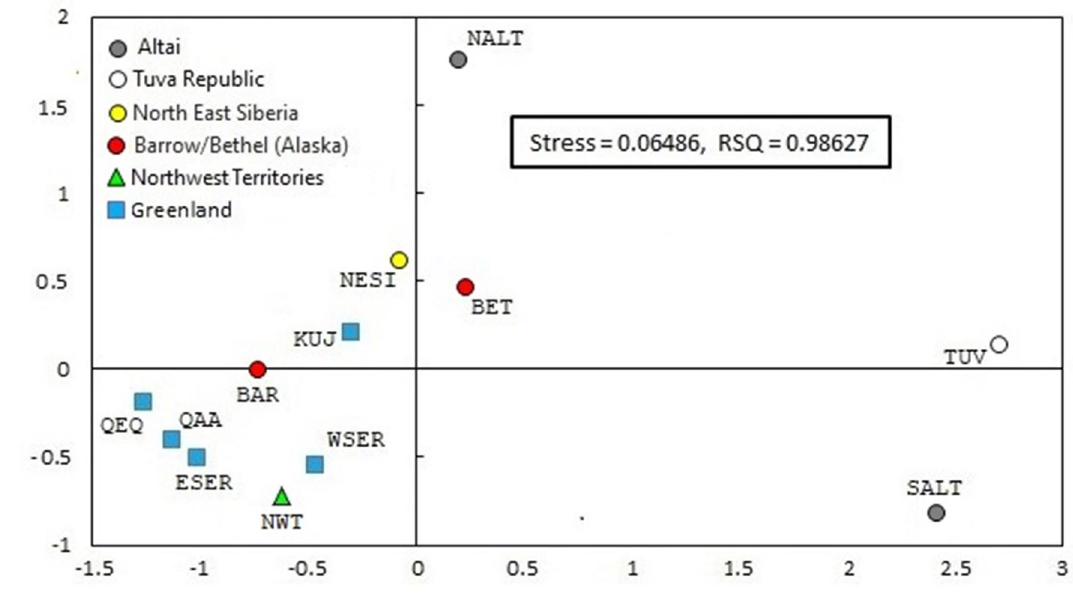
Figure 3. MDS plot of populations